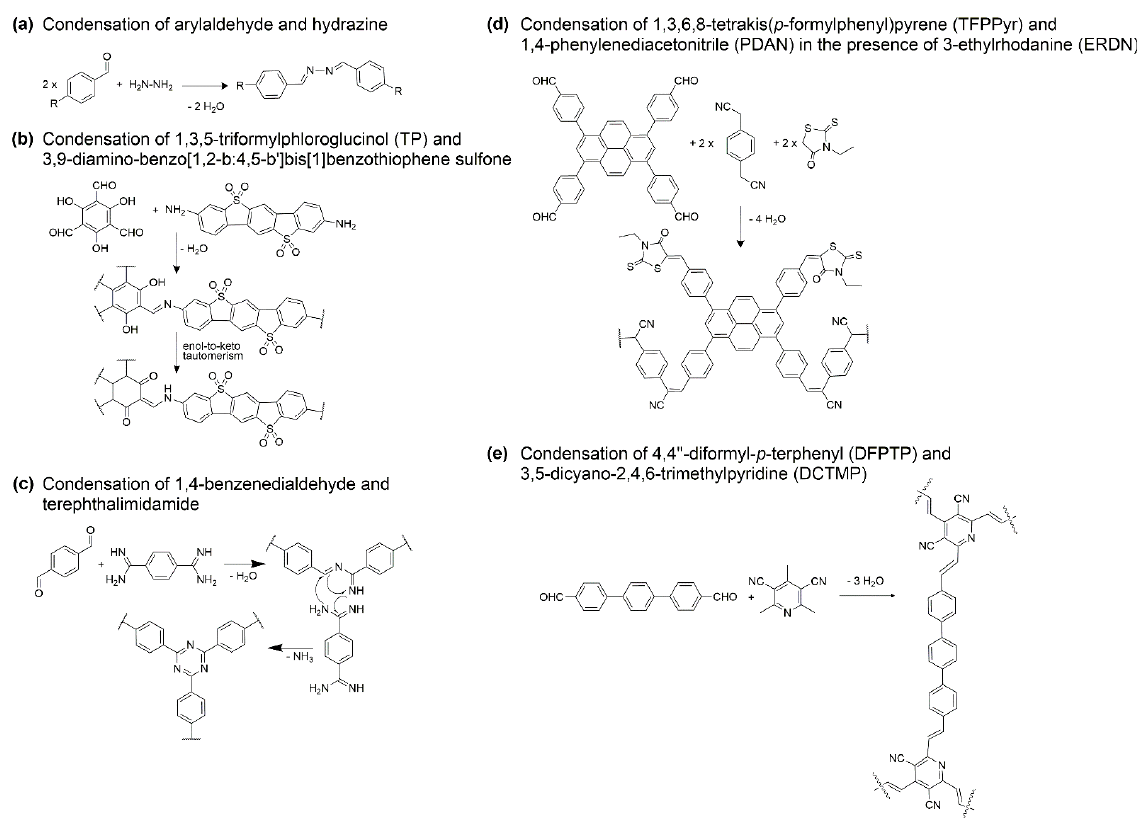
Figure 2. Selected condensation reactions to achieve the synthesis of COFs. Note that for the sake of simplicity only the reactivity of one end of both reactants is shown.